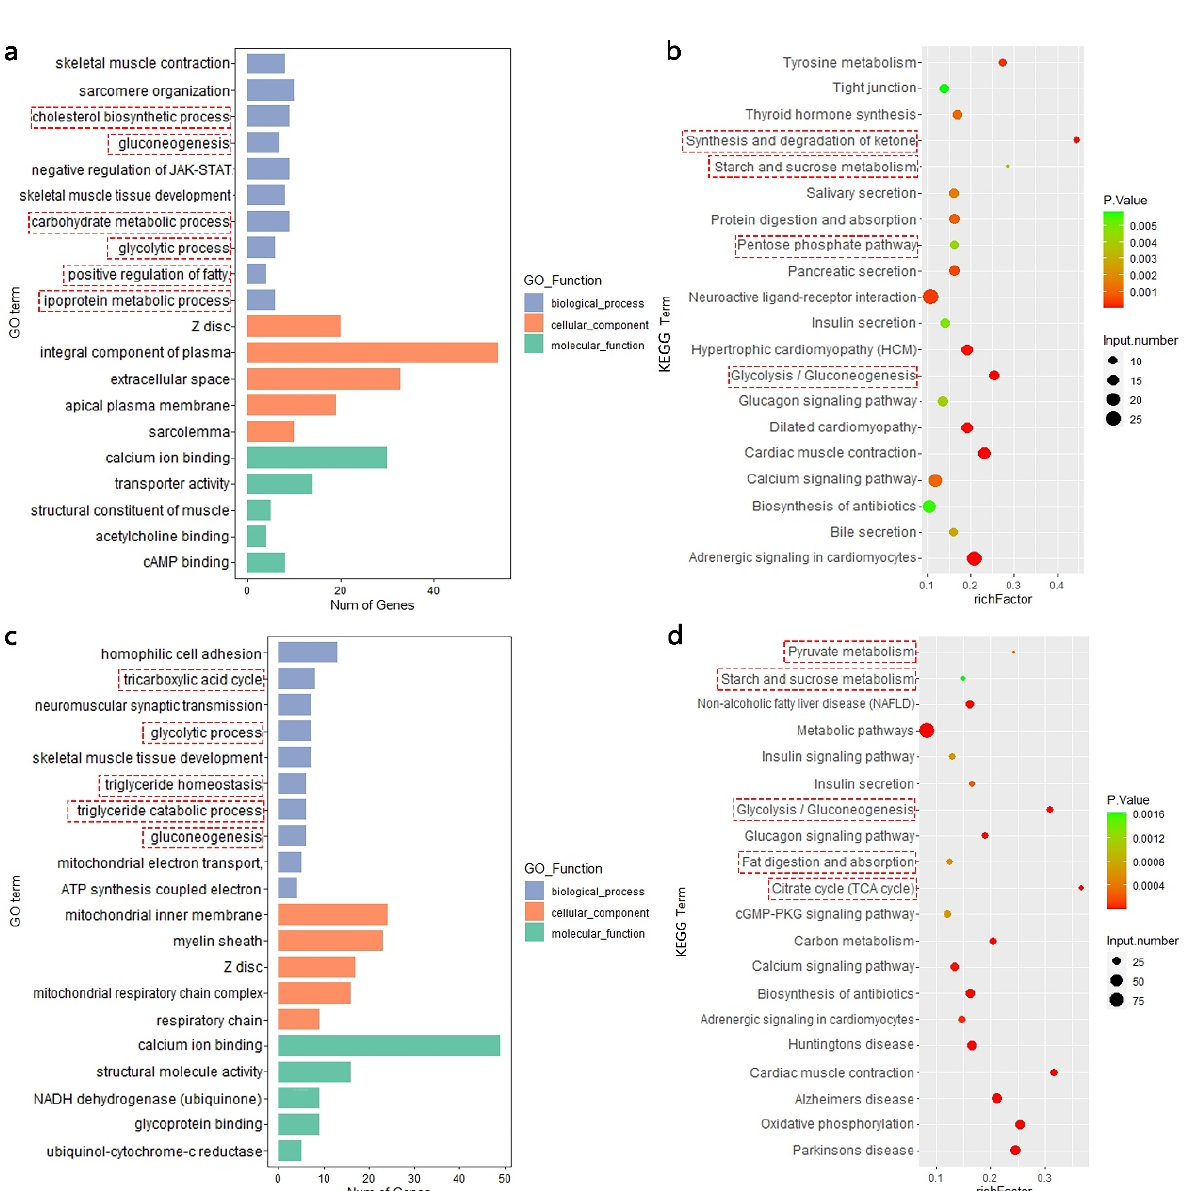
Figure 5. Functional enrichment analyses of differentially expressed genes (DEGs) and specific expressed genes (SEGs) based on pooling and biological replicate RNA sequencing (RNA-seq). ( a ) Gene Ontology (GO) annotation of DEGs in pooling RNA-seq; ( b ) Kyoto Encyclopedia of Genes and Genomes (KEGG) pathway analysis of DEGs in pooling RNA-seq; ( c ) GO annotation of DEGs in biological replicate RNA-seq; ( d ) KEGG pathway analysis of DEGs in biological replicate RNA-seq. The red boxes indicate the GO terms and KEGG pathways related to glucose and lipoid metabolism. ( a , c ) show the 10 most significant (FDR < 0.05) terms in the Biological Process (BP) class and the 5 most significant terms in the Cellular Component (CC) and Molecular Function (MF) classes. ( b , d ) show the most significant 20 pathways in the KEGG results.